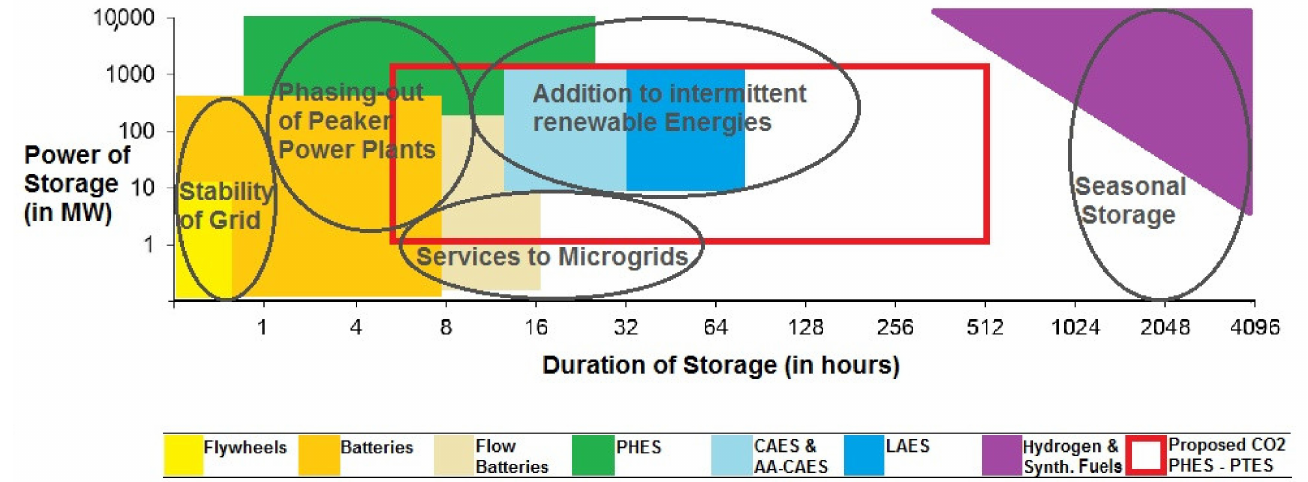
Figure 1. Chart of energy storage systems according to function, technology, power and